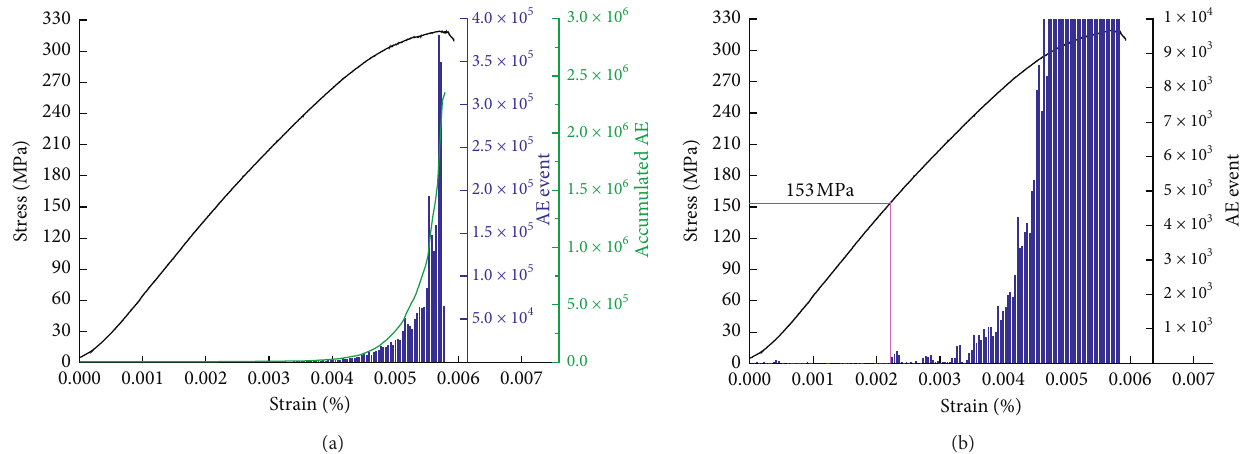
Figure 7: Typical AE monitoring data and stress-strain curve: (a) AE monitoring data and stress-strain curves; (b) AE data and cor- responding initial crack stress thresholds.